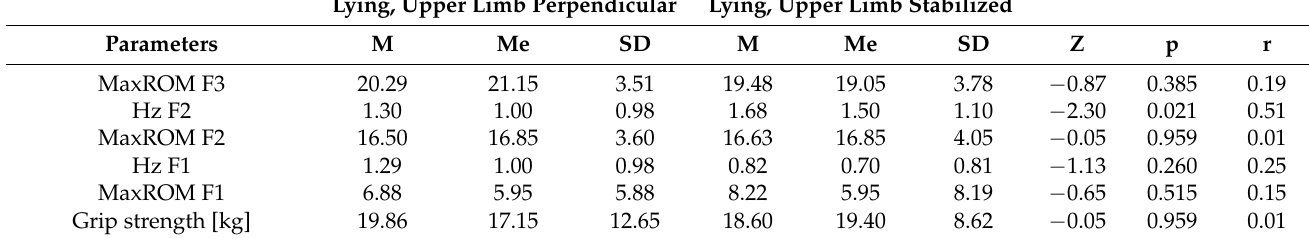
Table 8. Cont. Lying, Upper Limb Perpendicular Lying, Upper Limb Stabilized